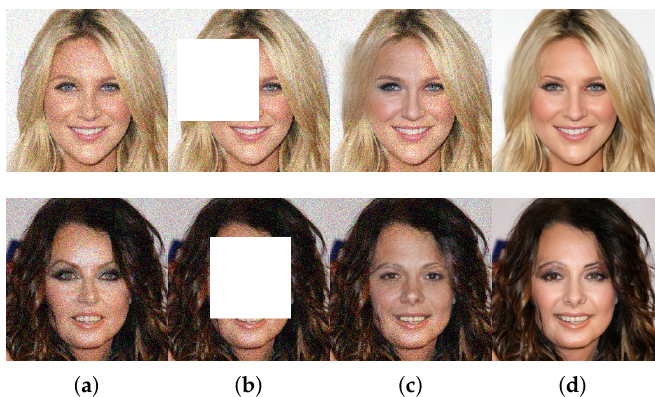
Figure 10. Completion results affected by the adversarial examples. ( a ) adversarial examples; ( b ) masked images; ( c ) completion results affected by noise; ( d ) completion results without